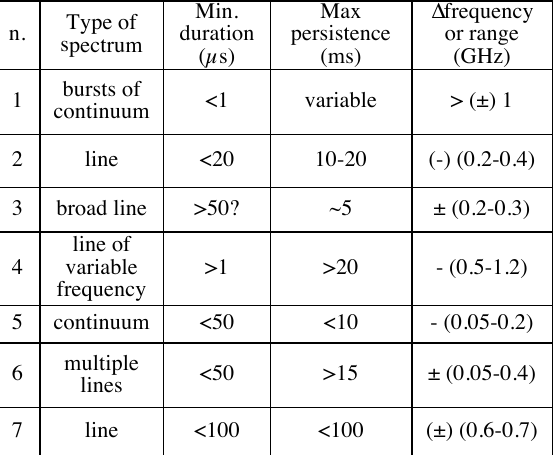
Table 1. Types of observed emission. Emissions of Type 2 and Type 7 are the ones studied in more detail in this paper. n.